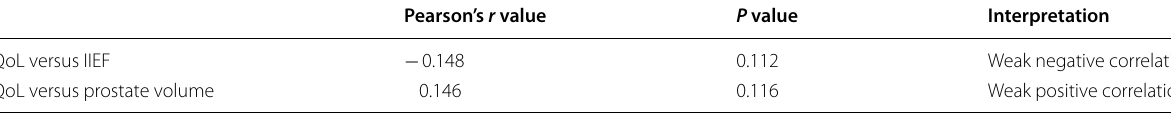
P value 0.211 = Table 7 Summary of correlation between QoL versus IIEF and prostate volume